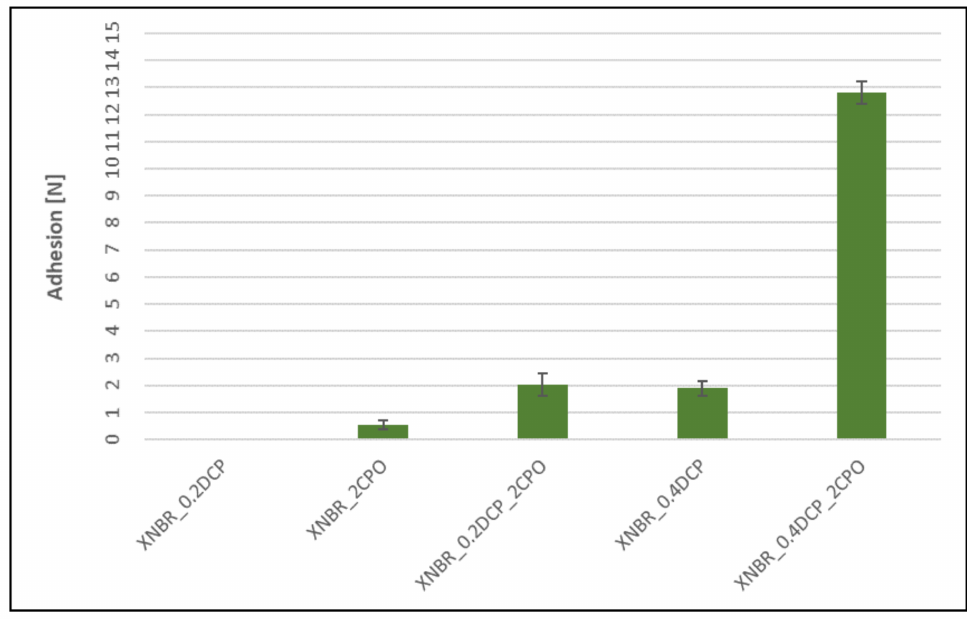
Figure 9. Influence of the peroxide curing system modification on adhesion between peroxide XNBR vulcanizates and silver wires (missing bars indicate the lack of